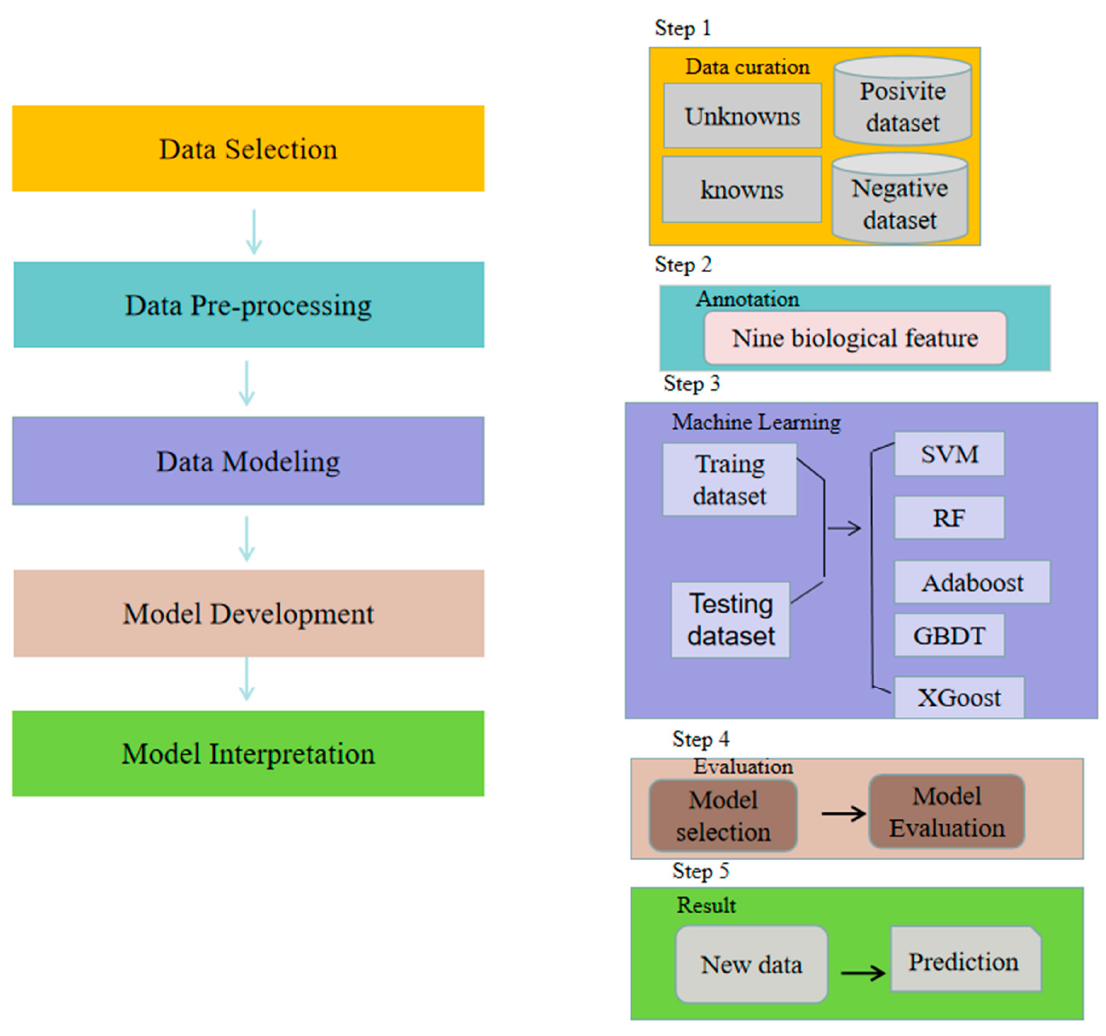
Figure 1. Workflow of the model framework.